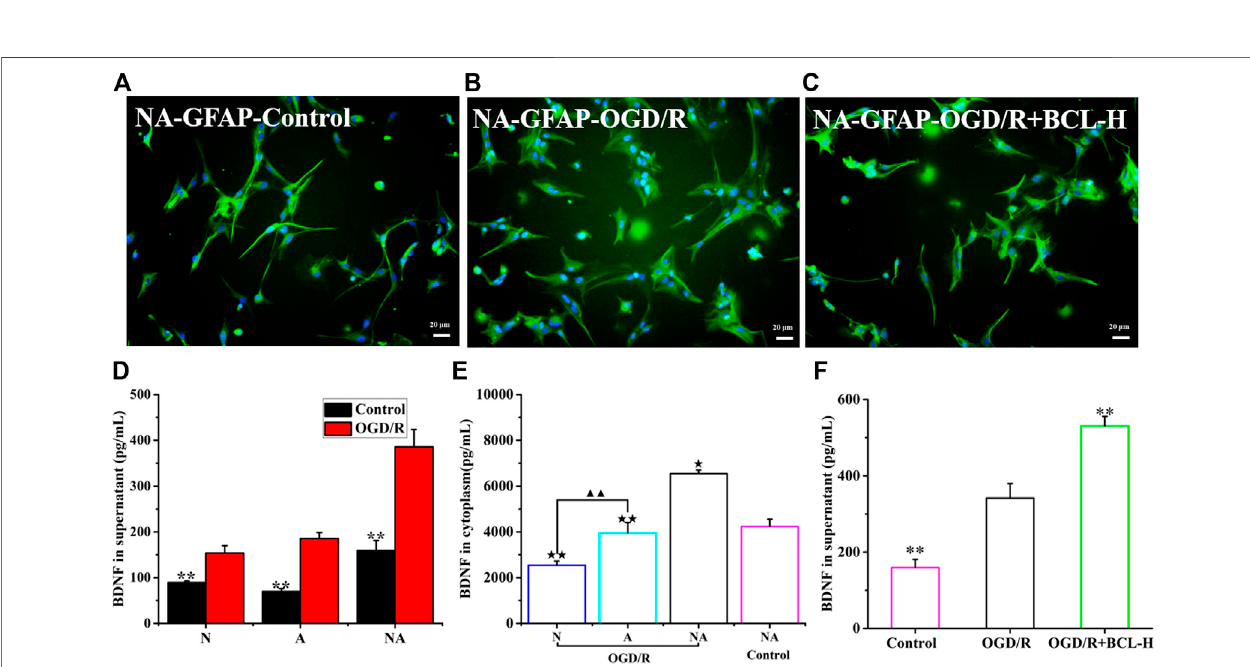
FIGURE 5 | Reactive astrocytes and BDNF secretion after OGD/R. (A) Morphology of astrocytes (GFAP) in the NA coculture system in the control group. (B) Morphologyofastrocytes(GFAP)intheNAcoculturesystemafterOGD/R. (C) TheeffectsofBCLonthemorphologyofastrocytesintheNAcoculturesystemafterOGD/ R. (D) BDNF release in the N group, A group, and NA group after OGD/R. (E) The level of BDNF in neuronal cytoplasm (N), astrocyte cytoplasm (A), and NA system. (F) The effects of BCL on BDNF release in the NA group after OGD/R. ++ p < 0.01, + p < 0.05 vs. NA + BCL-H + OGD/R group; ▲▲ p < 0.01, N OGD/R group vs. A OGD/R group; ** p < 0.01, vs. OGD/R